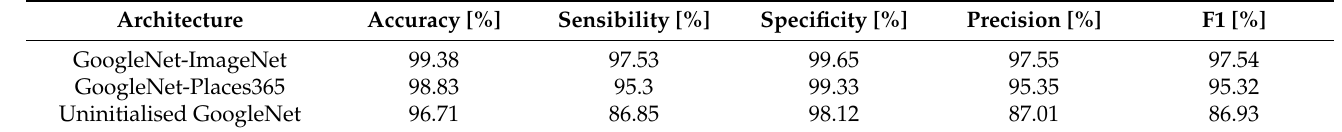
Table 4. GoogleNet training